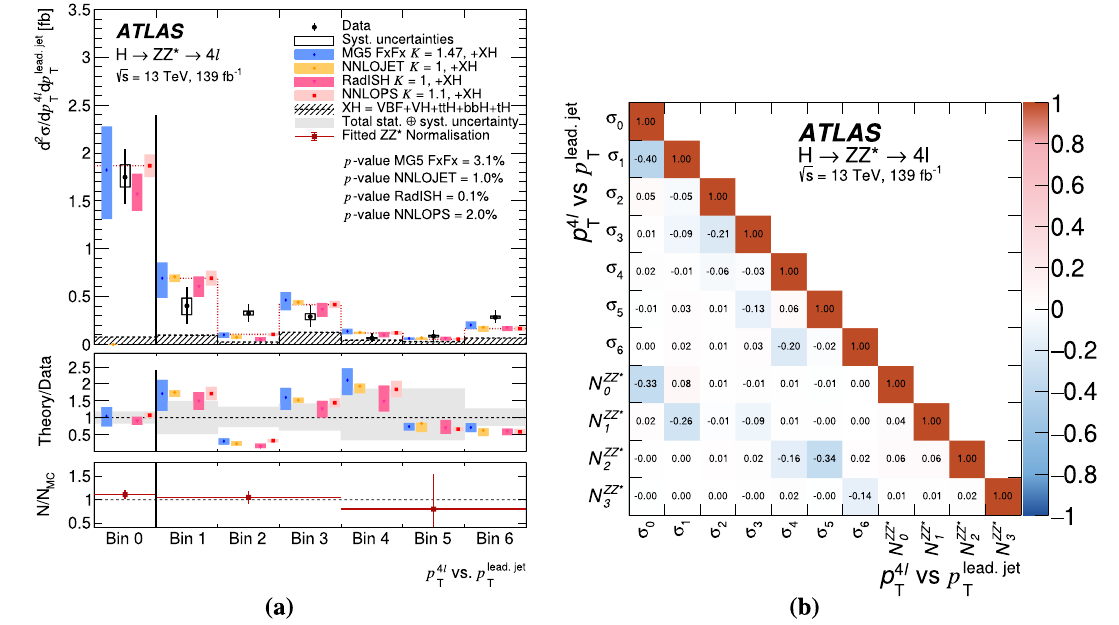
Fig. 37 a Double differential fiducial cross section for the transverse momentum of the four-lepton system vs. the transverse momentum of . jet the leading jet, p 4 (cid:3) vs. p lead , and b the corresponding correlation T T